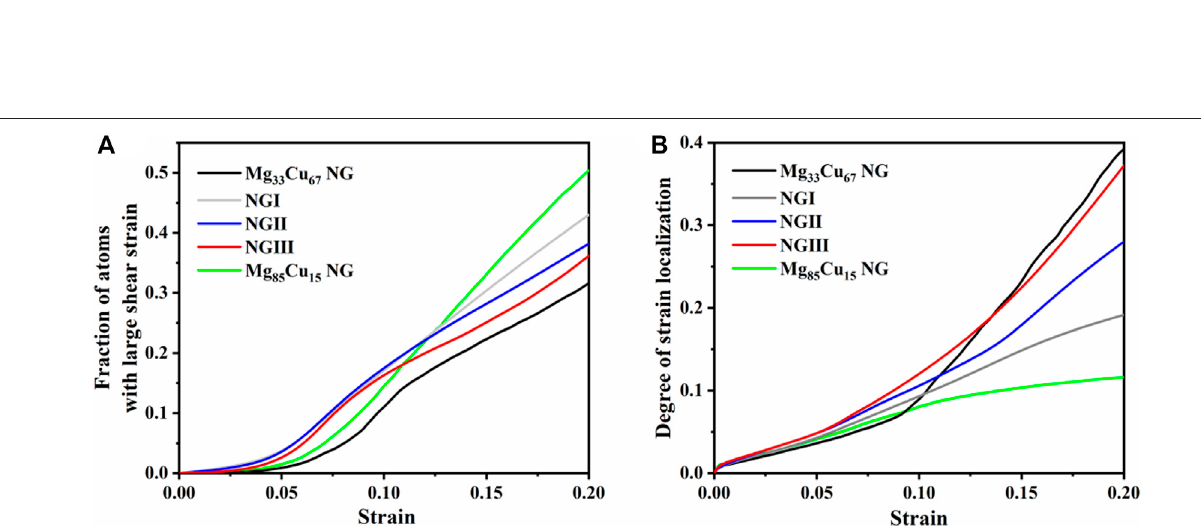
Frontiers in Materials |